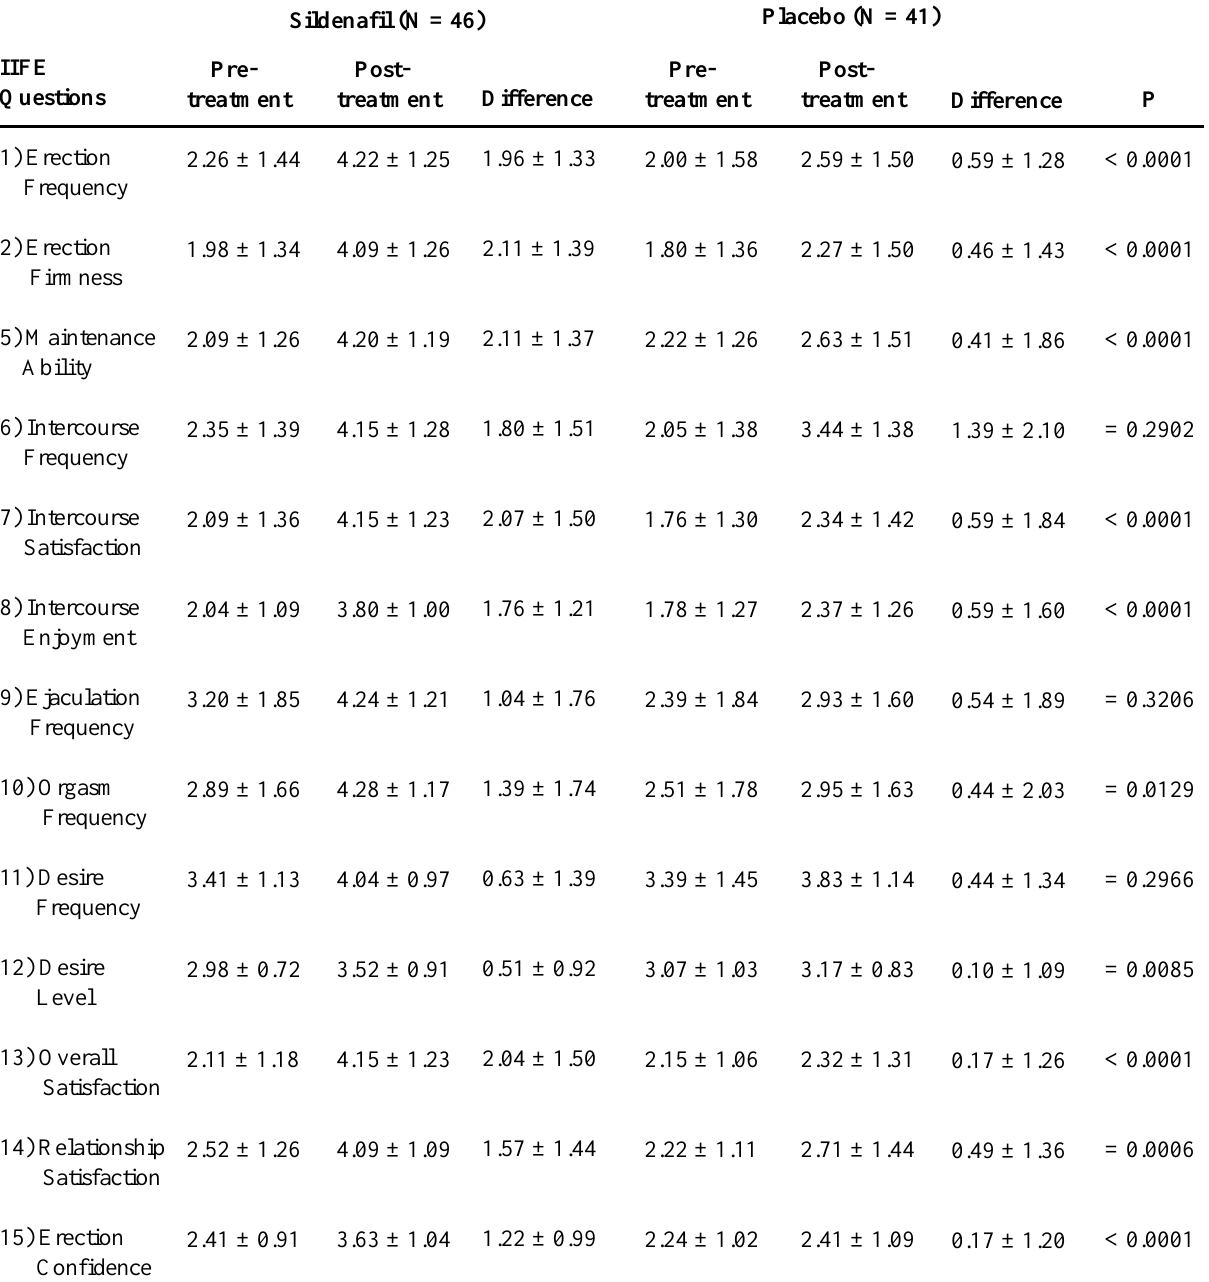
Table 3 – Mean ± standard deviation scores on questions 1, 2 and 5 to 15 of International Index of Erectile Function (IIFE). Evaluable sample, N =